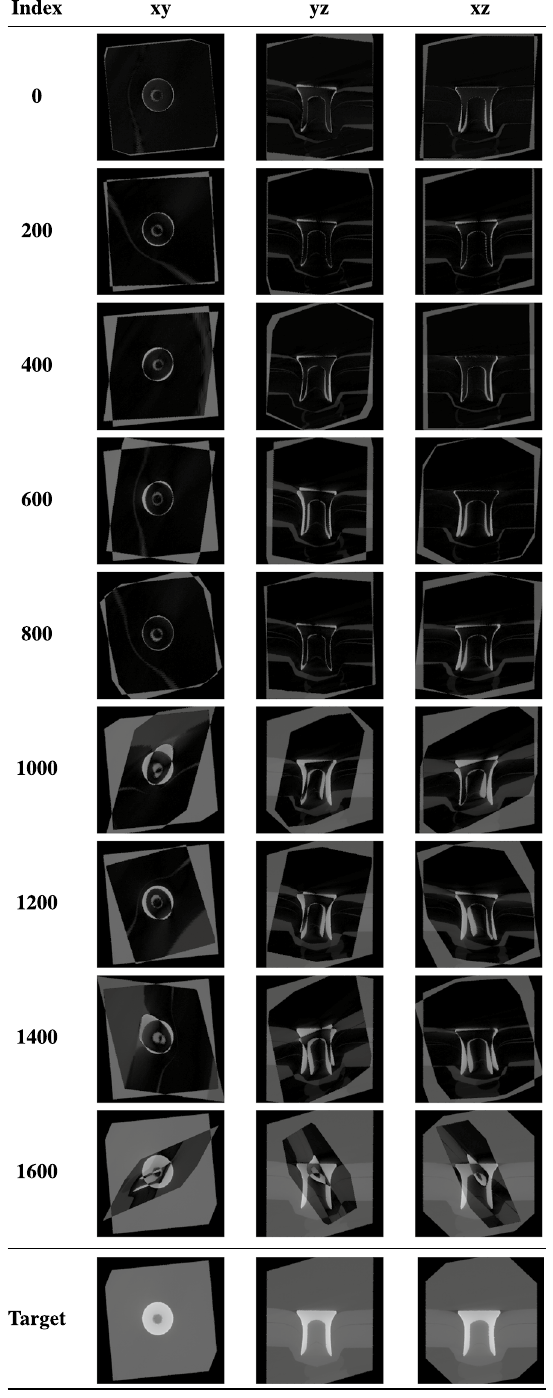
Fig. 9 Exemplary visualization of the severity of deviations from pure rotation matrices and the resulting warping effects. The indi- ces correspond to the x-axis of the bottom left graph in Fig. 6, which shows the mean and median errors of the predicted matri- ces in ascending order. The higher the index, the larger the devia- tion is. Here the Mix4 set was used as well. The difference between the target rotation and the prediction rotation is depicted. In other words, every image line shows three cutting planes (xy, yz, xz) of the subtraction of two volumes (target volume and volume after rotation with predicted matrix). If the prediction rotation resulted in a volume that is identical to the target volume (zero error), the volume subtraction would produce completely black images. Dark pixel values correspond to small deviations whereas bright ones correspond to large deviations. The first two rows (Index 0 & 200) show predominantly dark pixels, which indicates, that the predic- tion and the objective in the last row where almost